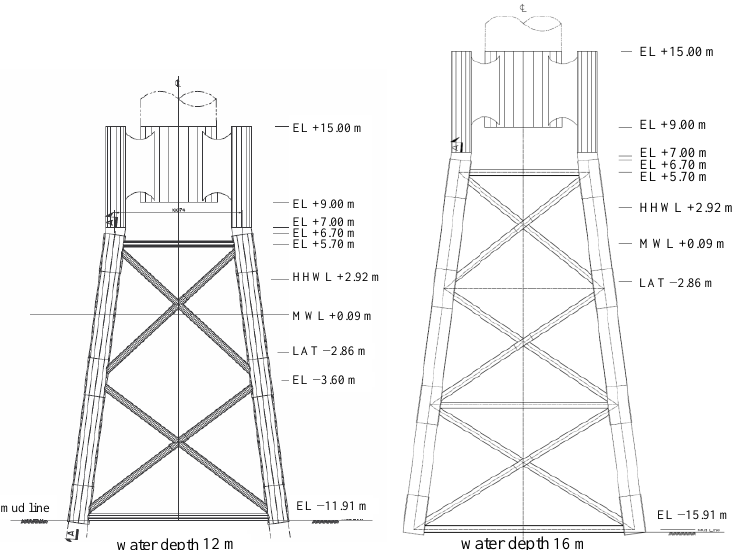
Figure 1. A sketch of the two locations (a water depth of 12 m and 16 m) of the jacket-type foundation (EL, Elevation; LAT, lowest astronomical tide; MWL, mean water level; HHWL, higher high water